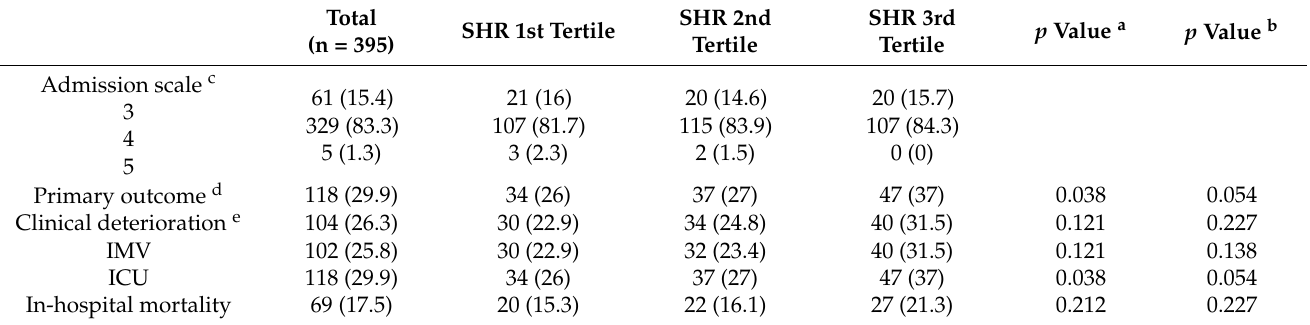
Table 2. The primary and secondary outcomes according to SHR tertiles.